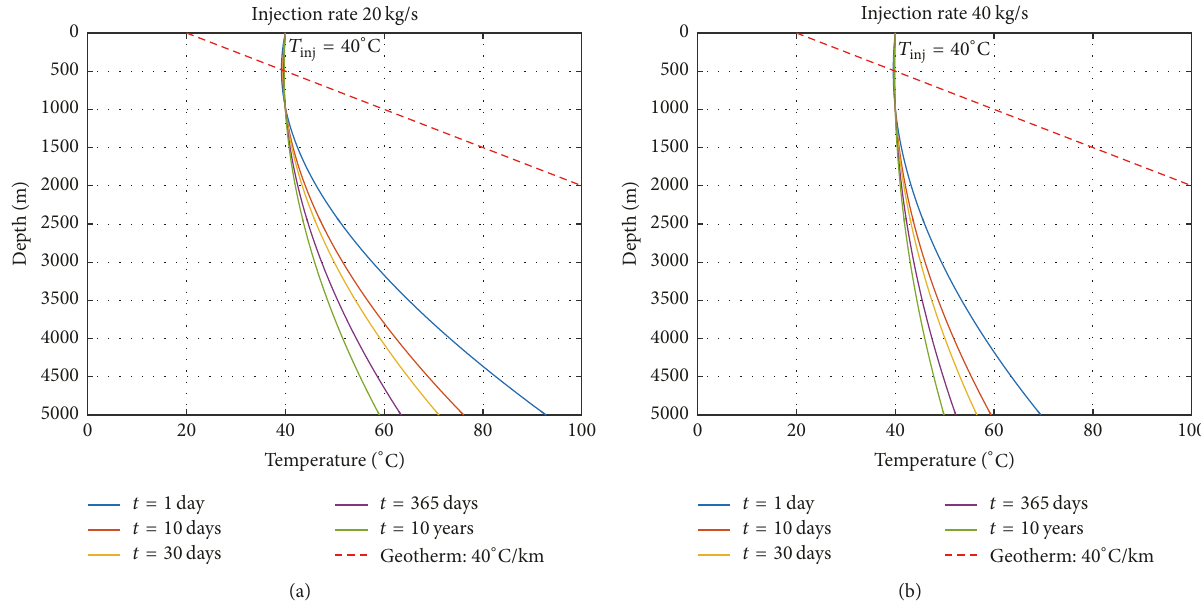
Figure 1: Temperature profiles in a 5 km deep injection well for an injection temperature of 40 ∘ C and an injection rate of 20 kg / s (a) and 40 kg / s (b).